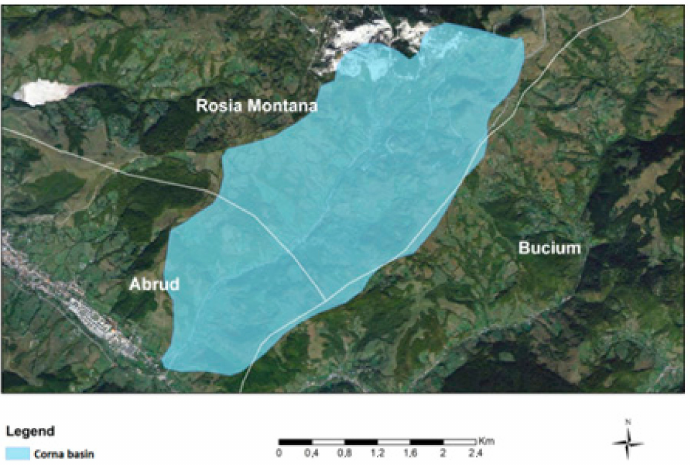
Figure 3. Administrative-territorial units in which the Corna Valley falls: Ro¸sia Montan ă , Abrud and